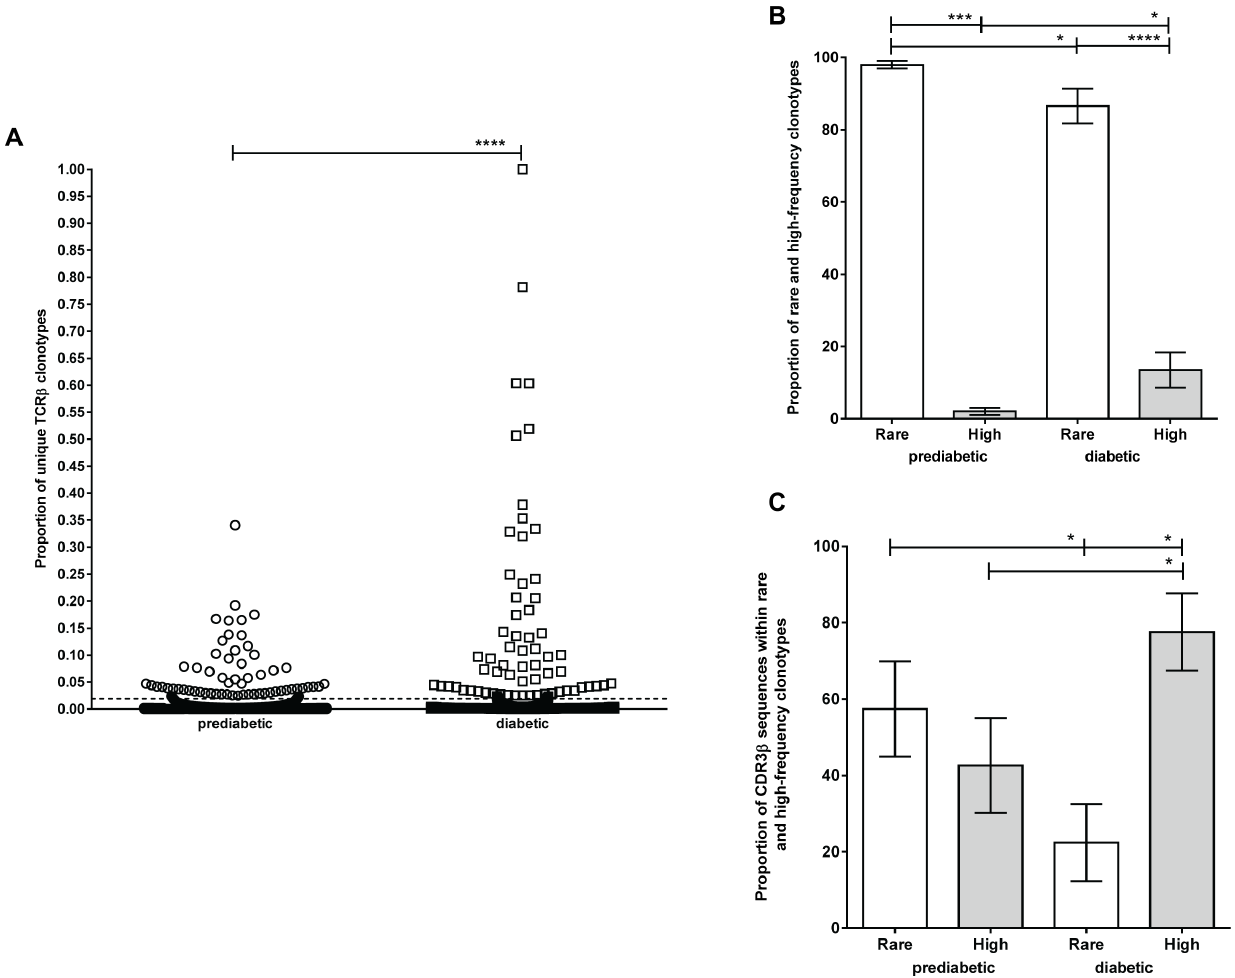
Figure 2. High-frequency CD4 + CD44 high clonotypes are more common in the islets of diabetic than prediabetic NOD mice. CD4 + CD44 high cells from the islets of 10-week-old prediabetic (n=7) and newly diabetic (n=9) NOD female mice were sorted and subjected to high- throughput sequencing of the CDR3 b regions. (A) Scatter plot showing the normalized frequencies of all CDR3 b sequences represented by unique TCR b clonotypes (15,923 in prediabetic mice and 1,471 in diabetic mice, shown as dots). Clonotypes accounting for , 0.02% and $ 0.02% of all CDR3 b s were defined as rare and high-frequency clones, respectively. (B) The proportion of rare (white bar) and high-frequency (gray bar) clonotypes in prediabetic and diabetic mice. Rare clonotypes are significantly more common than high-frequency clonotypes in prediabetic (p=0.0006) and diabetic mice (p , 0.0001). Rare clonotypes are significantly more frequent in prediabetic than in diabetic mice (p=0.0118), and high-frequency clonotypes are significantly more frequent in diabetic than in prediabetic mice (p=0.0118). (C) The proportion of CDR3 b sequences derived from rare (white bar) and high-frequency (gray bar) clonotypes in prediabetic or diabetic mice. The proportion of CDR3 b sequences derived from rare clonotypes is significantly higher in prediabetic than in diabetic mice (p=0.0168). The proportion of CDR3 b sequences derived from high-frequency clonotypes is significantly higher in diabetic than in prediabetic mice (p=0.0168). The proportion of CDR3 b sequences derived from high-frequency clonotypes is significantly higher than sequences derived from rare clonotypes in diabetic mice